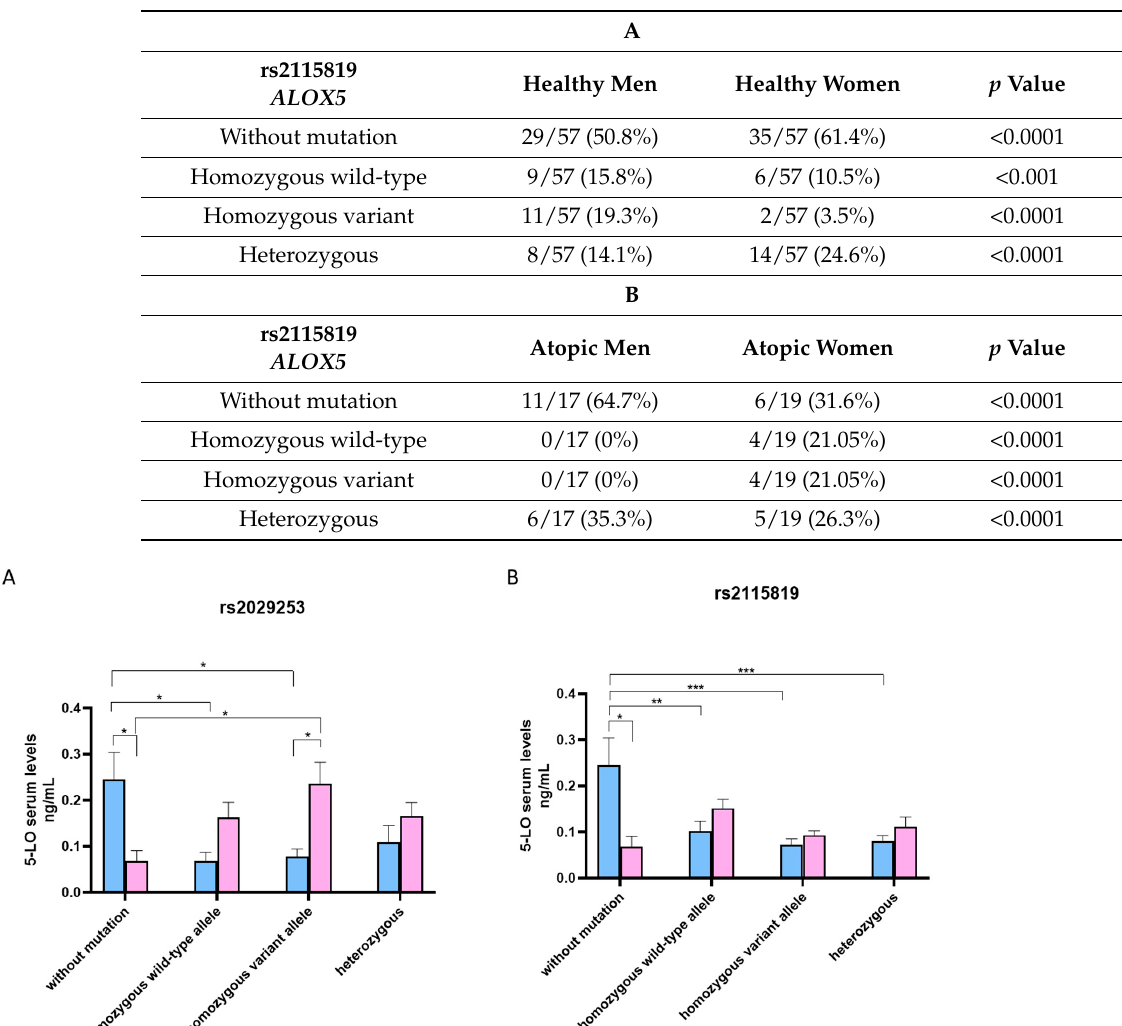
Table 5. Genotype and allele frequency in Healthy ( A ) and Atopic ( B ) M and W, based on the ALOX5 rs2115819 polymorphism. The statistical tests used in these analyses were the one-way analysis of variance followed by the Tukey Multiple Comparison Test.